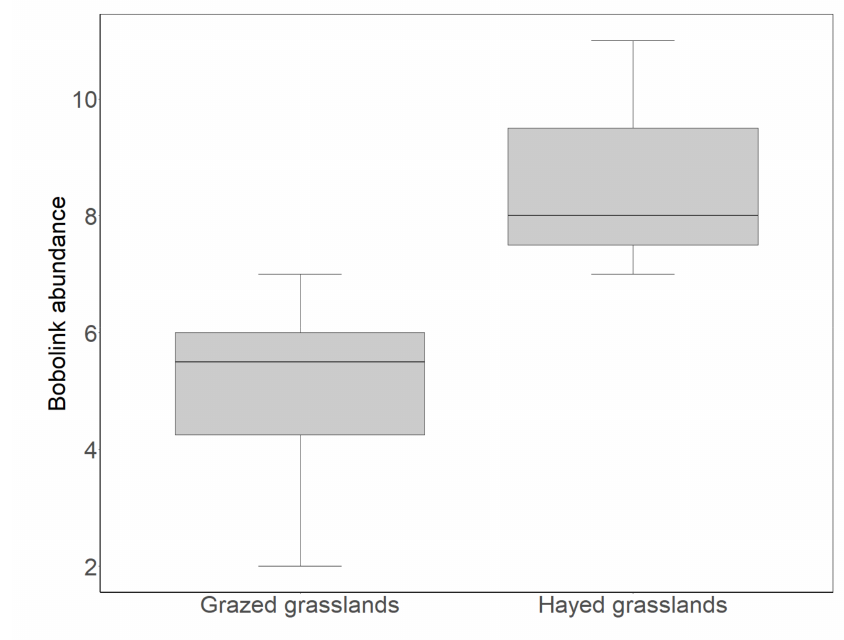
Figure 3. Boxplot showing total Bobolink abundance (unique individuals captured/year) in 2017–2019 on grasslands grazed by bison and cattle compared to grasslands where hay was harvested after the bird breeding season on conservation grasslands in Nebraska, USA. Black lines in each box represent the median value of the abundance, while the lower and upper box edges represent the 25th and 75th percentile of the abundance, respectively. Error bars represent the 5th and 95th percentiles of the